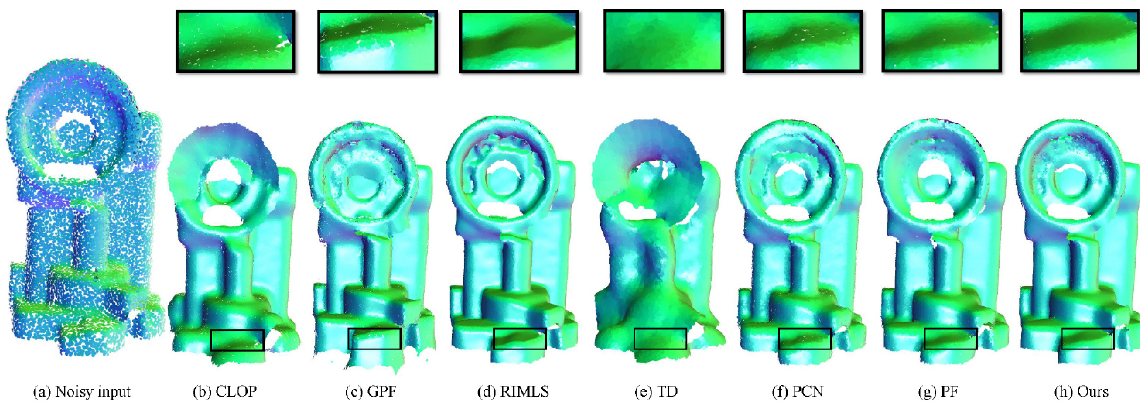
Fig. 11 Upsampling results on the Realscan raw scanned